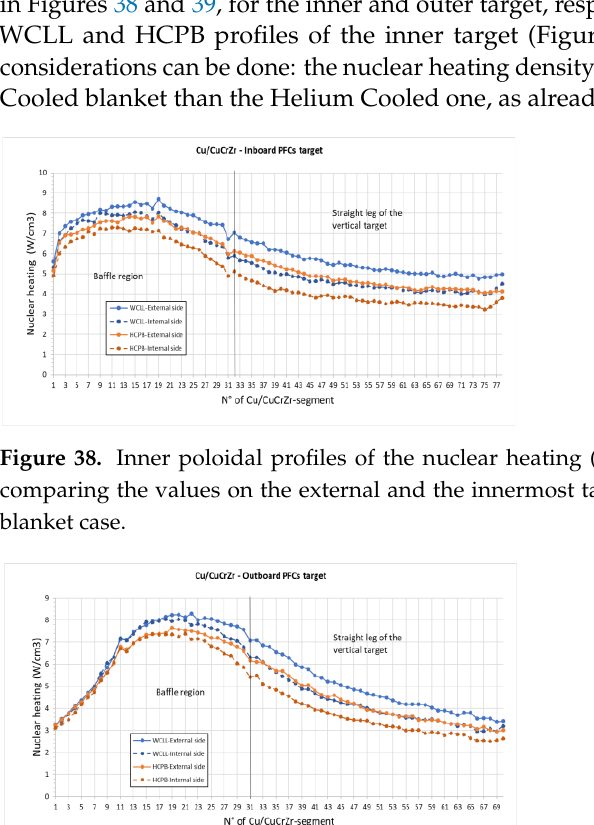
Figure 39. Outer poloidal profiles of the nuclear heating (W/cm 3 ) on Cu/CuCrZr components, com-